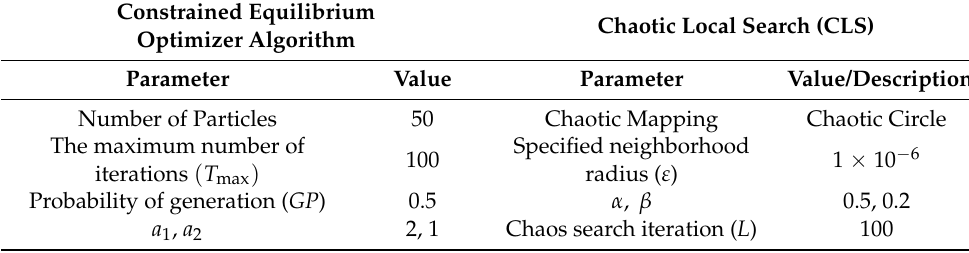
Table 1. The parameters setting.